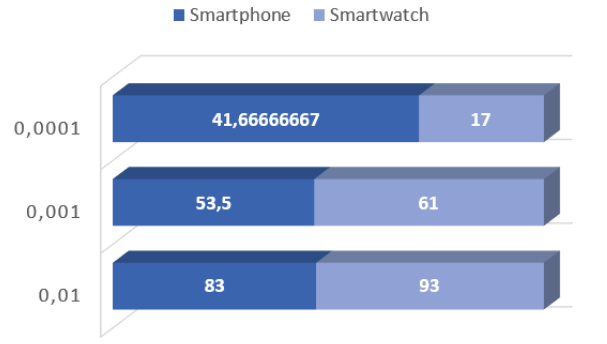
Figure 3. The value of prizes for the work (3 hidden layers) done in the proposed methodology.